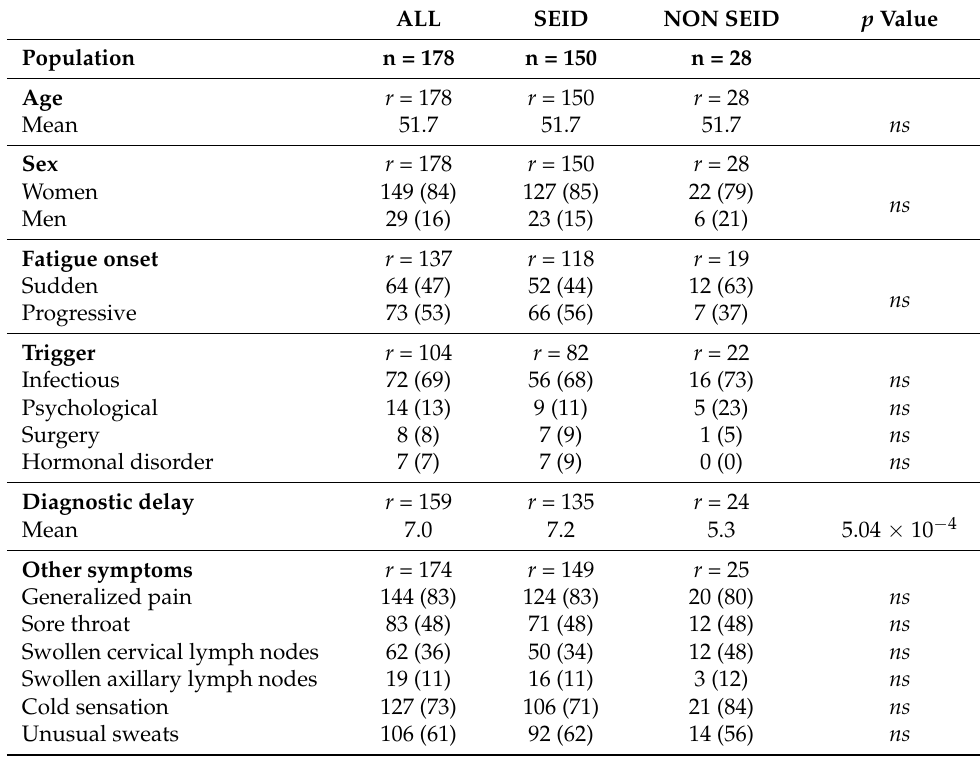
Table 1. Characteristics of all subjects and comparison between SEID and non-SEID patients. r number of respondents to each item; (%); ns , not